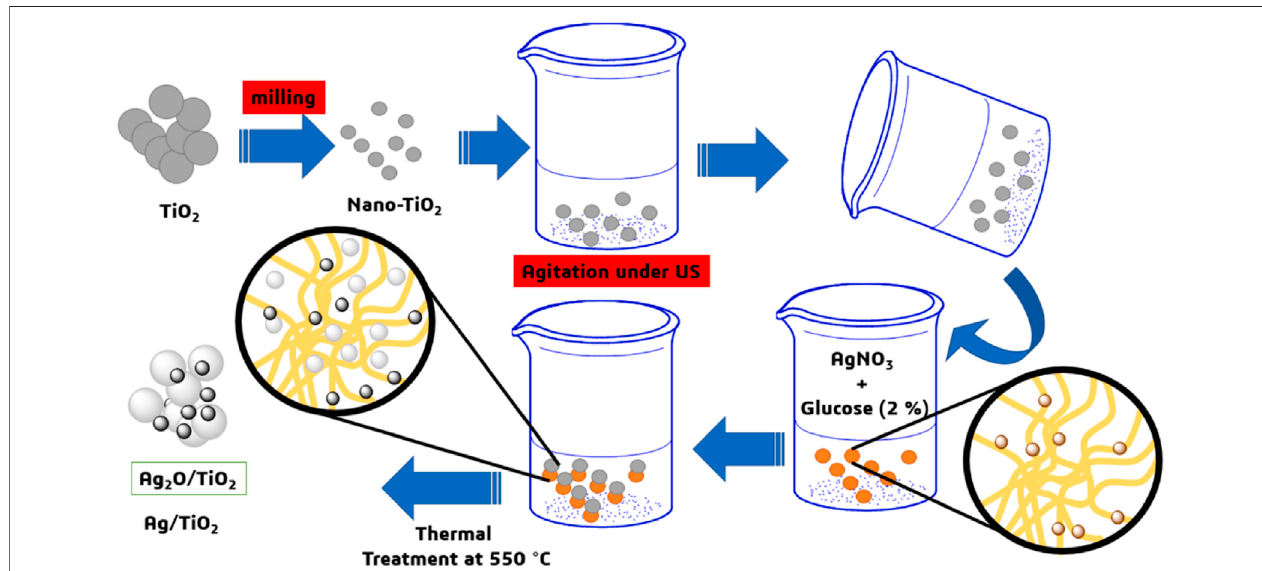
FIGURE 2 | Preparation fl ow chart of silver-doped TiO 2 nanoparticles prepared by the glucose-assisted ball-milling method. Adapted from Ellouzi et al. (2021). Copyright © 2021 Elsevier B.V.